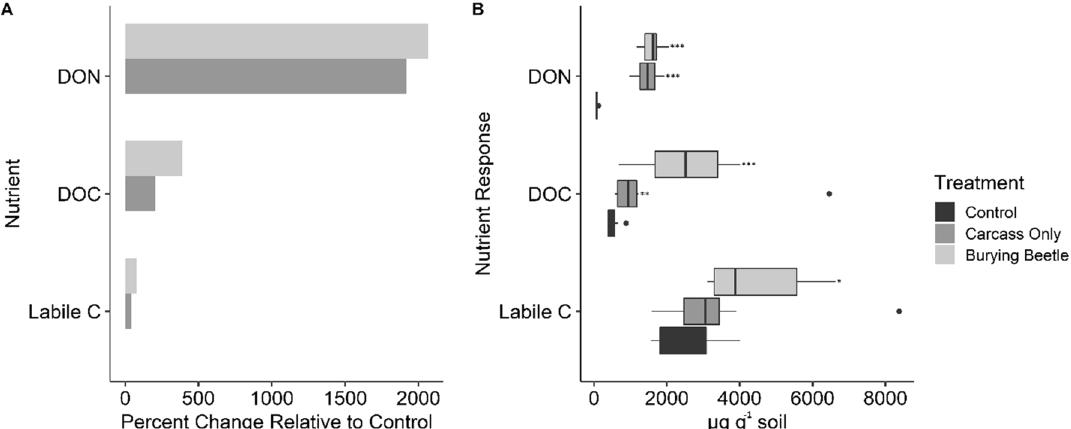
Figure 2. ( A ) Percent increase in each soil nutrient relative to the control and ( B ) changes in soil nutrient levels according to treatment. Dark grey indicates the control, gray indicates the carcass only treatment, and light grey indicates treatments with both carrion and burying beetles. Nutrient abbreviations: Dissolved organic nitrogen (DON), Dissolved organic carbon (DOC) and Labile Carbon (Labile C). Boxplot elements are as follows: center line, meidan; box limits, upper and lower quartiles; whiskers, 1.5 × interquartile range; points, outliers. Levels of significance relative to the control is indicated as follows: * significant at P < 0.05; ** P < 0.01 and *** P <